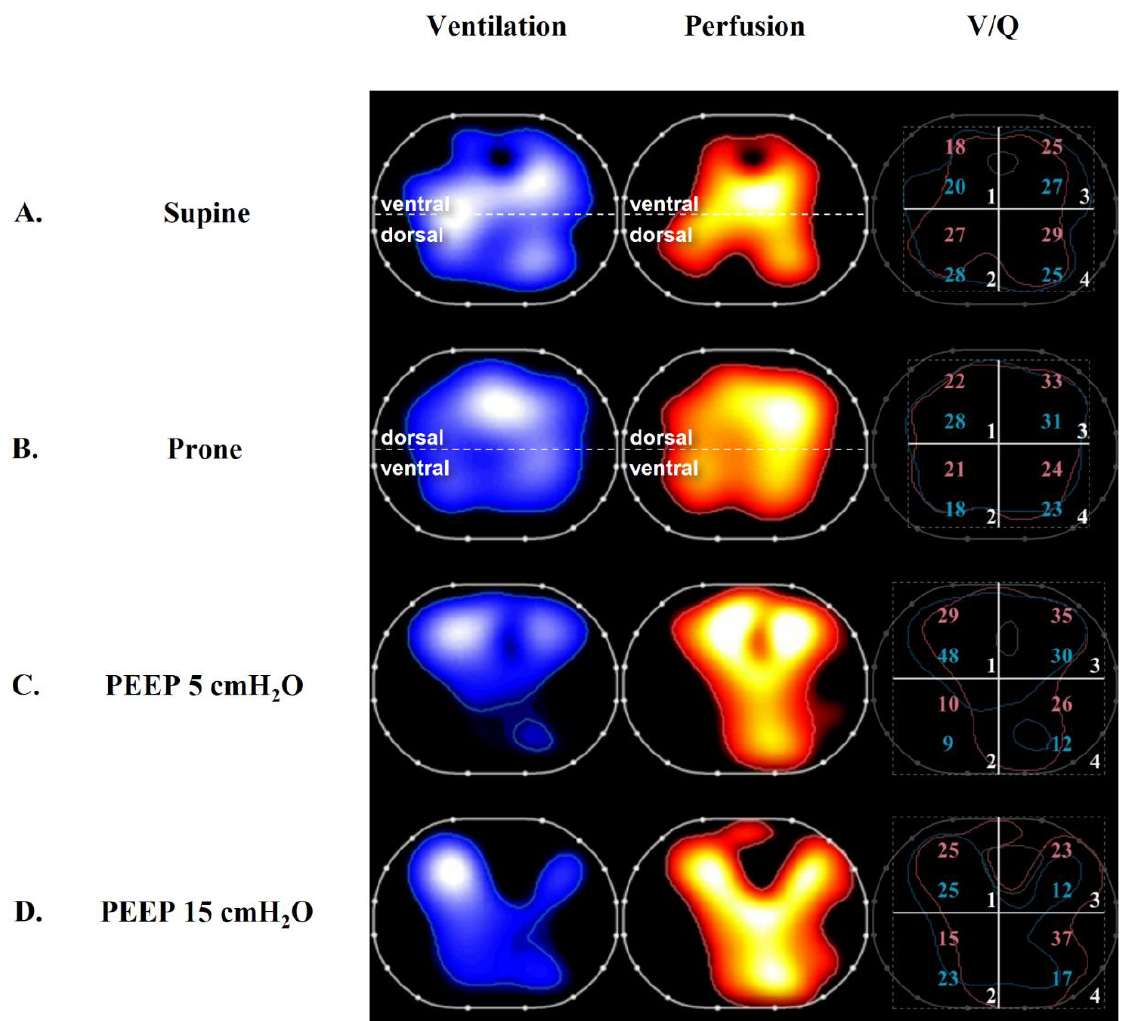
Figure 3. Evaluation of ventilation and perfusion maps at the bedside using electrical impedance tomography. Left-side blue panels display the regional distribution of ventilation. The red-colored middle panels display the regional distribution of perfusion (see text for details). Right-sided panels show the superposition of the contours of the ventilation and perfusion maps. The percentages of ventilation and perfusion for each of the four quadrants are annotated as blue and red numbers, respectively. (Row A ) was obtained from a patient with COVID-19-associated acute respiratory distress syndrome (ARDS) ventilated in the supine position. The maps displayed in (row B ) were obtained from the same patient during ventilation in the prone position, resulting in a reduction in ventilation-perfusion mismatch [60]. (Row C ) illustrates an ARDS patient in the supine position with a set PEEP of 5 cmH 2 O. (Row D ) was obtained from the same patient in the supine position after PEEP was increased to 15 cmH 2 O, resulting in an increase in the size of the ventilated area and improved superposition of the ventilation and perfusion maps [63].